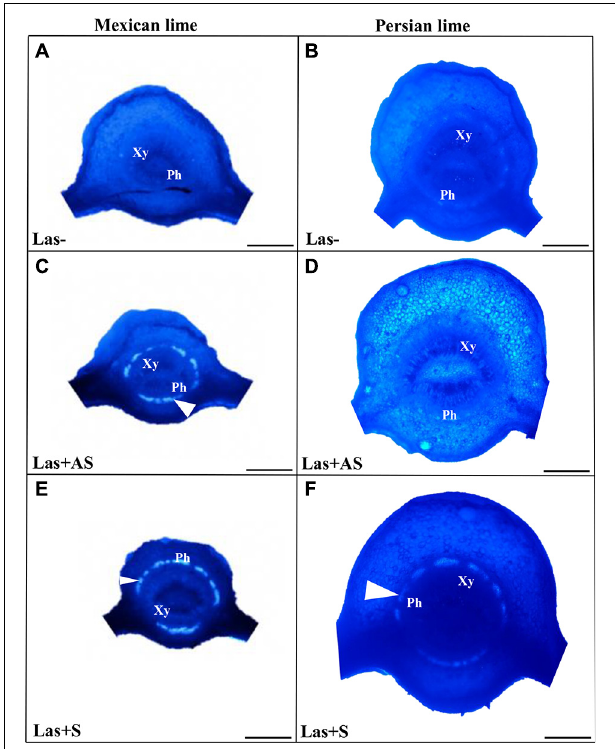
FIGURE 3 | Aniline blue staining of the petioles of the control (Las − ; A,B ) as well as infected leaves that were asymptomatic (Las + AS; C,D ) and symptomatic (Las + S; E,F ) from Mexican and Persian limes, respectively. White triangles indicate the presence of callose deposition at the phloem location (Xy: xylem and Ph: Phloem). Bars = 0.5